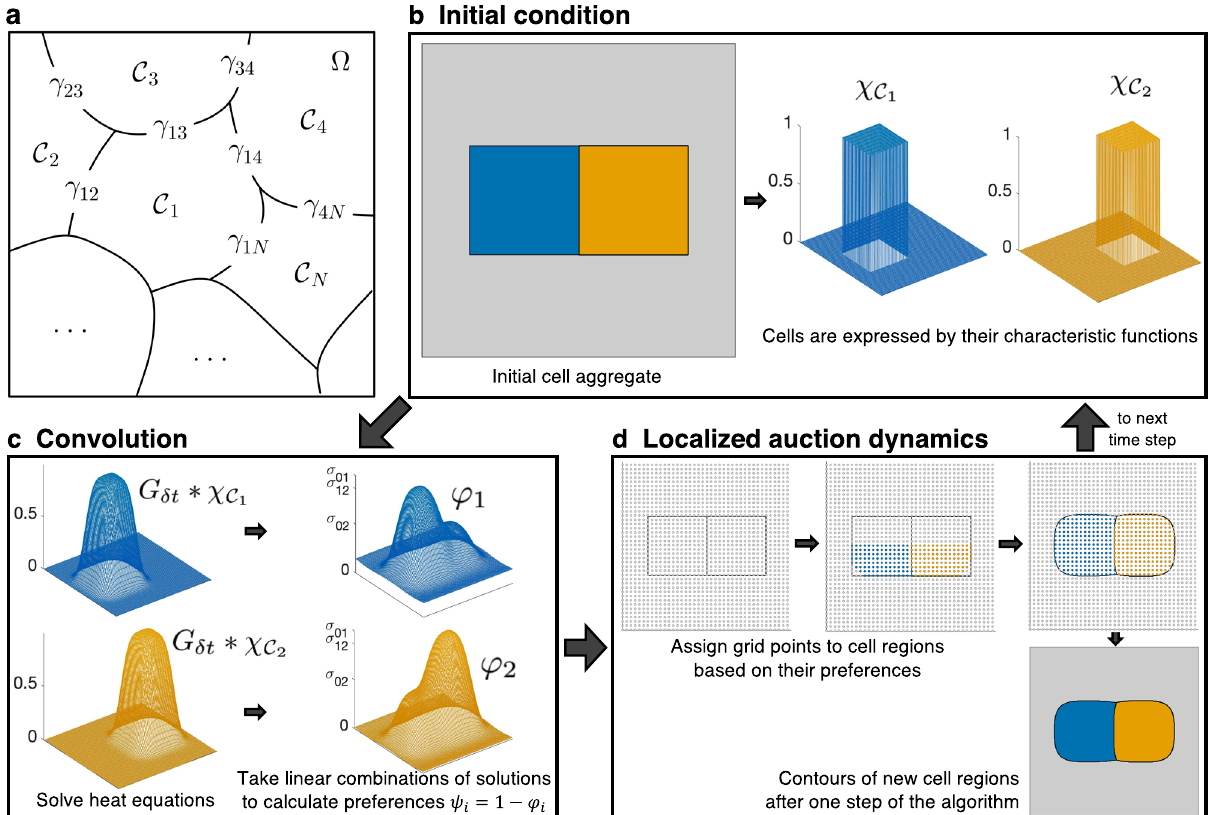
Fig. 1 Basic notation and outline of the algorithm. a A cellular aggregate is represented as a bounded domain Ω partitioned into N cells C 1 ; ¼ ; C N . The boundary between cells C i and C j denotes the cell-cell junction γ ij . b – d Three main steps of the algorithm generating an approximation of the cellular rearrangement at the next time step δ t : Initial condition ( b ). Given an initial cell aggregate, it is represented by characteristic functions χ C respective cell regions on a discrete grid (functions corresponding to the gray region are not shown). Convolution ( c ). Characteristic functions are diffused via solving heat equation, that is, convolutions with Gaussian kernel G δ t (cid:2) χ C with weights corresponding to interfacial tensions σ ij , i.e., φ i ¼ ∑ N j node x for belonging to cell region C i . Localized auction dynamics ( d ). Grid points are assigned to cell regions in several sweeps of auction-like process where grid points bid to neighboring cells based on the preferences ψ i . Level sets of the fi nal bid b ( x ) determine the cell con fi guration at the next time step δ t , which optimizes preferences while preserving cell volumes (see also Supplementary Movie